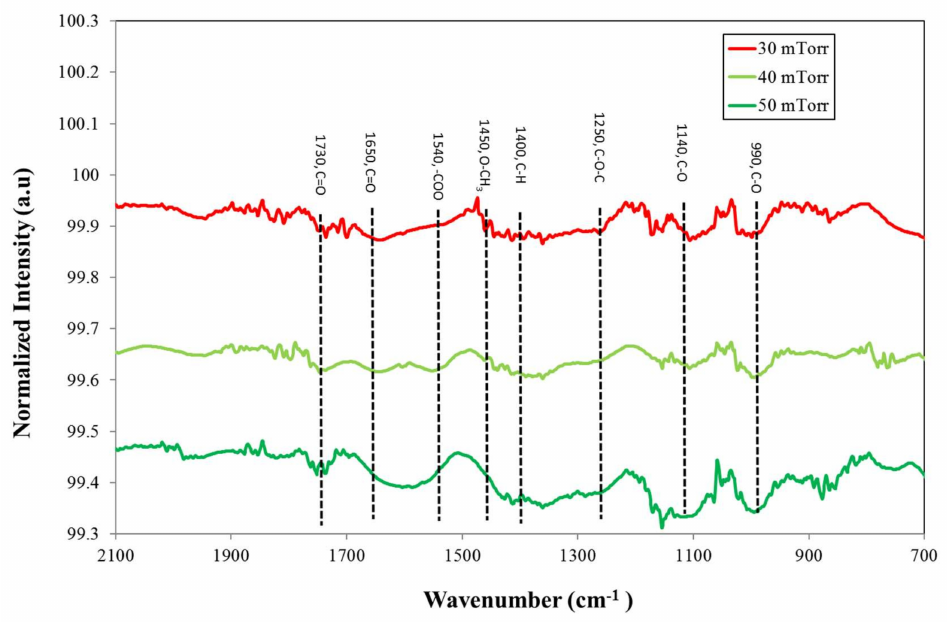
Figure 13. The FTIR spectra for PP-MMA films deposited with the variation in working